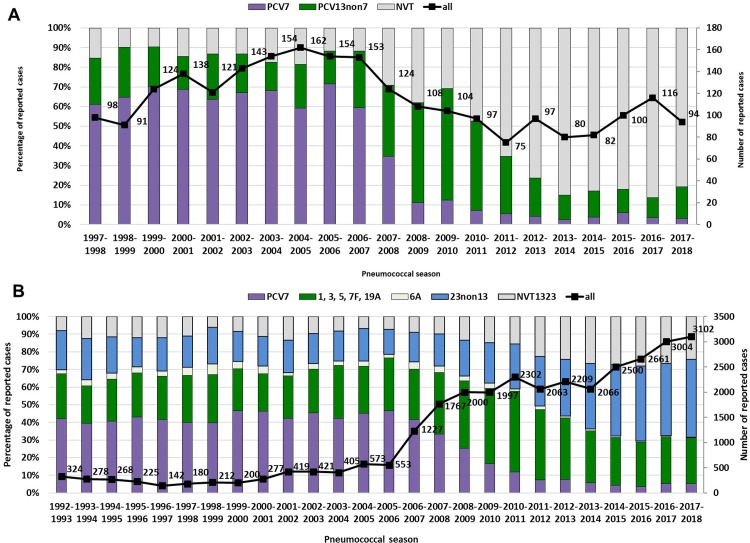
Theoretical serotype coverage of PCV7 and PCV13 among (A) children < 2 years of age and (B) PCV7, PCV13 and PPV23 among adults ≥16 years of age with IPD in Germany. NVT1323: serotypes not included in PCV13 or PPV23. Bars correspond to left vertical axis, line corresponds to right vertical axis. Stacked bar for PPV23 serotypes should be interpreted without the bar for serotype 6A.